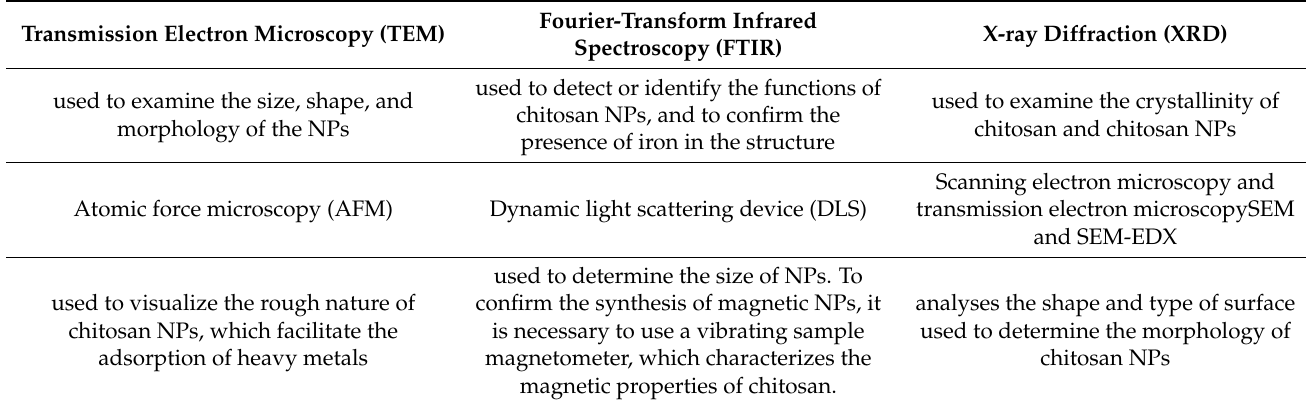
Table 1. Methods commonly used to characterize chitosan